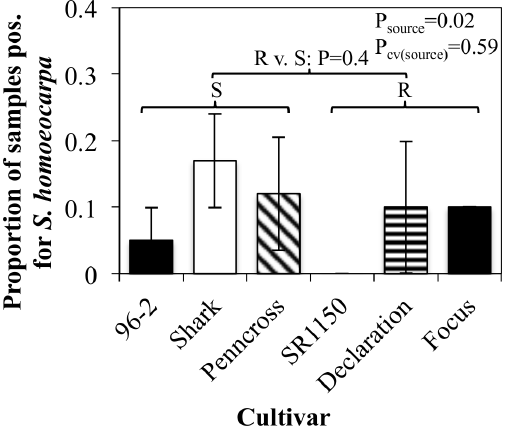
Figure 3. Results of nested PCR detection of Sclerotinia homoeocarpa DNA in creeping bentgrass commercial seed lots. Columns reflect the average proportion of samples positive for S. homoeocarpa contamination across the two lots of each cultivar. Shading indicates cultivar source: ‘96-2’, ‘Focus,’ and ‘SR1150’ were from a single source while ‘Shark,’ ‘Penncross,’ and ‘Declaration’ were from different seed distributors. Error bars represent 6 one standard error of the mean. Source and cv(source) P-values are from ANOVA of the data with the normal distribution and a =0.05. The P-value for R versus S cultivars was obtained from a pre-planned orthogonal